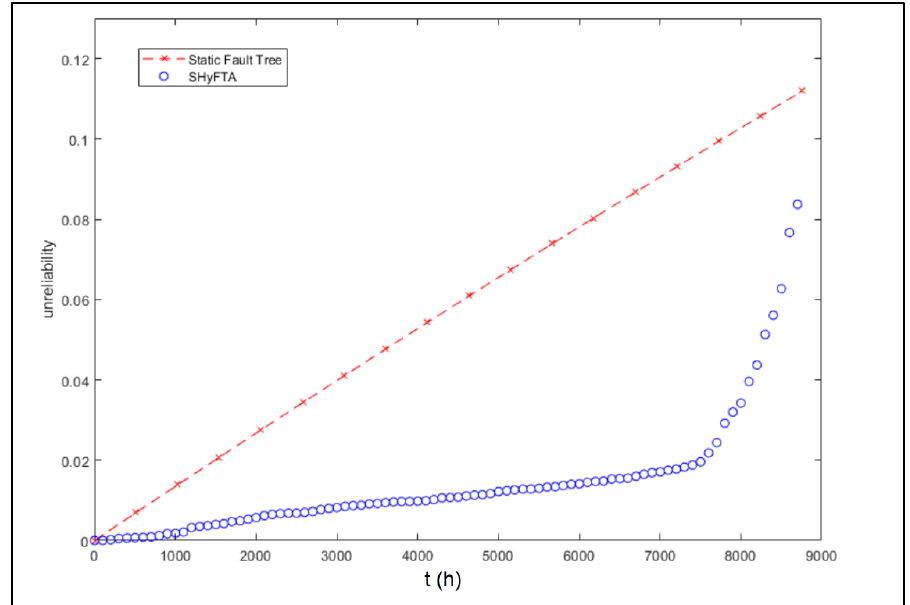
Figure 10. Unreliability of the electric motor and comparison with the static Fault Tree model result.